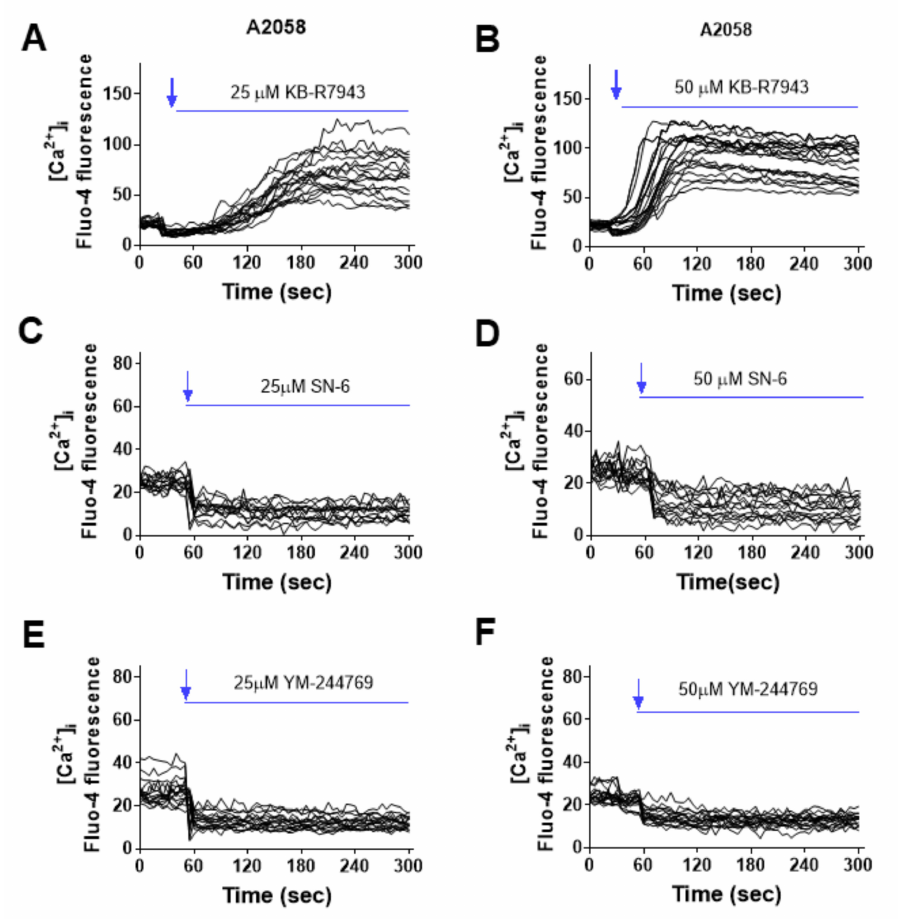
Figure 3. Effect of KB-R7943, SN-6 and YM-244769 on the level of cytosolic Ca 2+ ([Ca 2+ ] i ) in A2058 melanoma cells. ( A , B ) Flua-4 AM loaded A2058 melanoma cells were perfused with KB-R7943 (25 or 50 µ M) in the solution containing 2 mM Ca 2+ . KB-R7943 elevated cytosolic Ca 2+ level. ( C , D ) A2058 cells were loaded with Flua-4 AM, imaged and perfused with SN-6 (25 or 50 µ M). ( E , F ) Ca 2+ imaging traces of A2058 cells that were perfused with YM-244769 (25 or 50 µ M). The recording traces were representatives of 3 separate experiments; n = 14–18 cells were imaged per